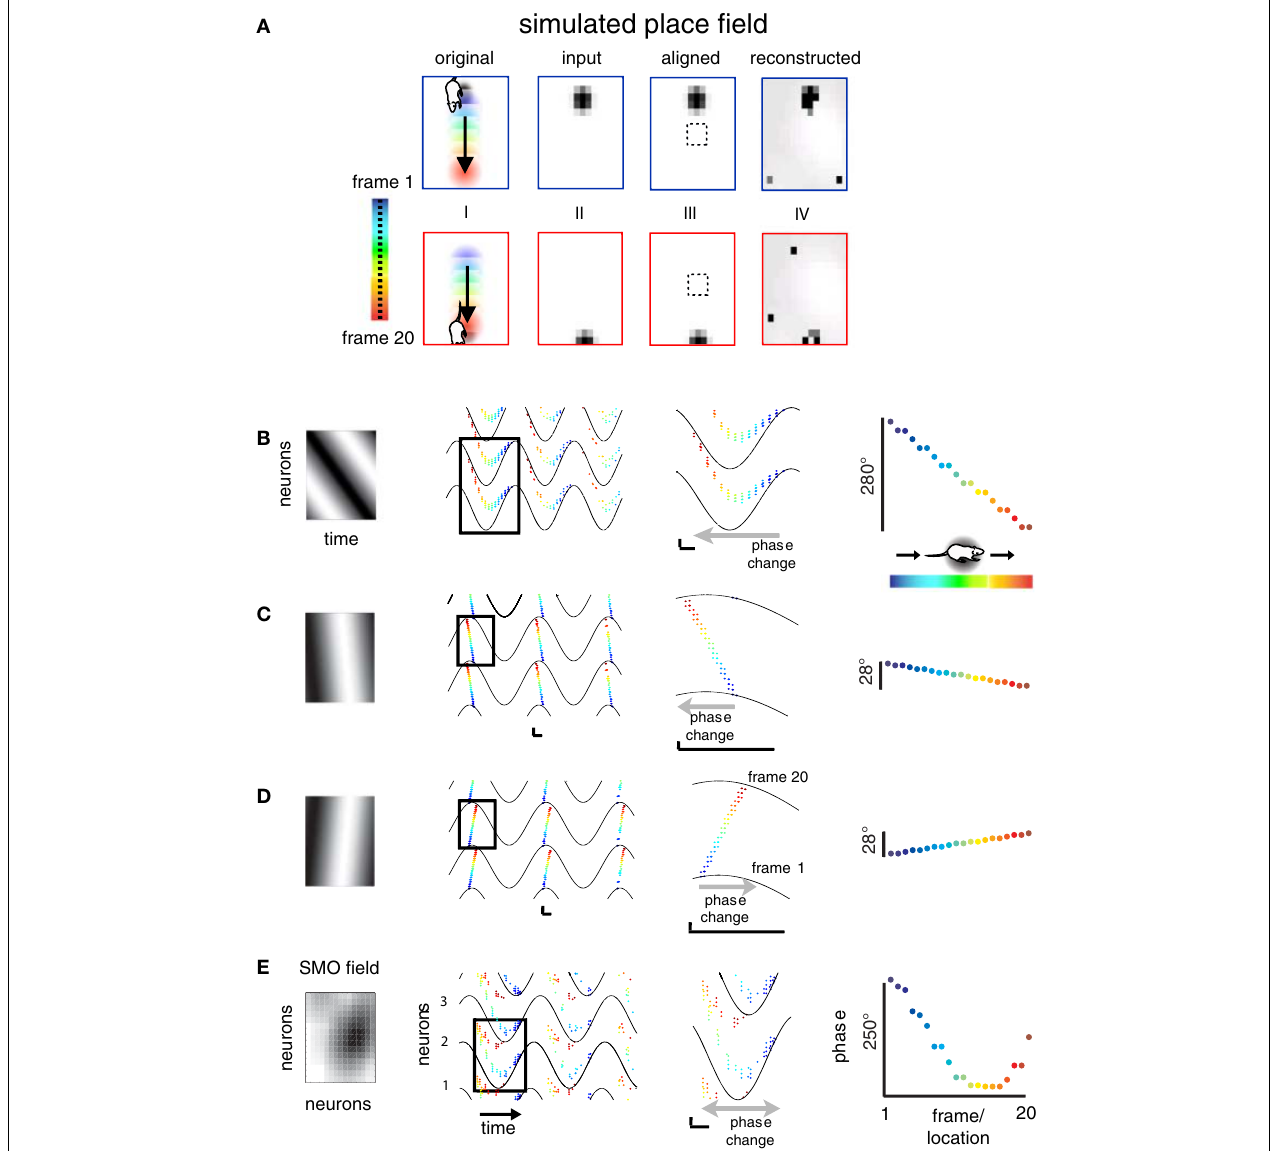
outlined area [dashed rectangle on (A) ]. The APs evoked by consecutive frames are projected between the SMO waves of adjacent neurons and color-coded according to the input frame in (A) corresponding to the rat’s location. The abscissa represents the time of the APs. The forth panels represent the phase of APs during a single run as a function of the rat’s location. (B) When a traveling wave SMO fi eld gradient was applied the neurons expressed a monotonically advancing AP phase precession spanning 280 ° theta phase angle. (C) By reducing the phase gradient of SMO ten times the AP phase precession angle decreased proportionally to 28 ° . In both examples (B,C) the traveling direction of SMO was set to be the opposite to the place cell activation sequence. (D) We reversed the direction of phase precession relative to (B,C) from monotonically increasing advancements to monotonically increasing delays by changing the SMO phase gradient such that it traveled in the direction of the activation sequence of neurons. (E) A bidirectional AP phase precession was enabled by a radially propagating SMO fi eld, where the AP phases advanced continuously until the animal reached the place fi eld center [outlined area in (A) ] and developed an increasing delay as the animal exited. Phase scale bars represent ¼ π . Arrows signify the directions of phase